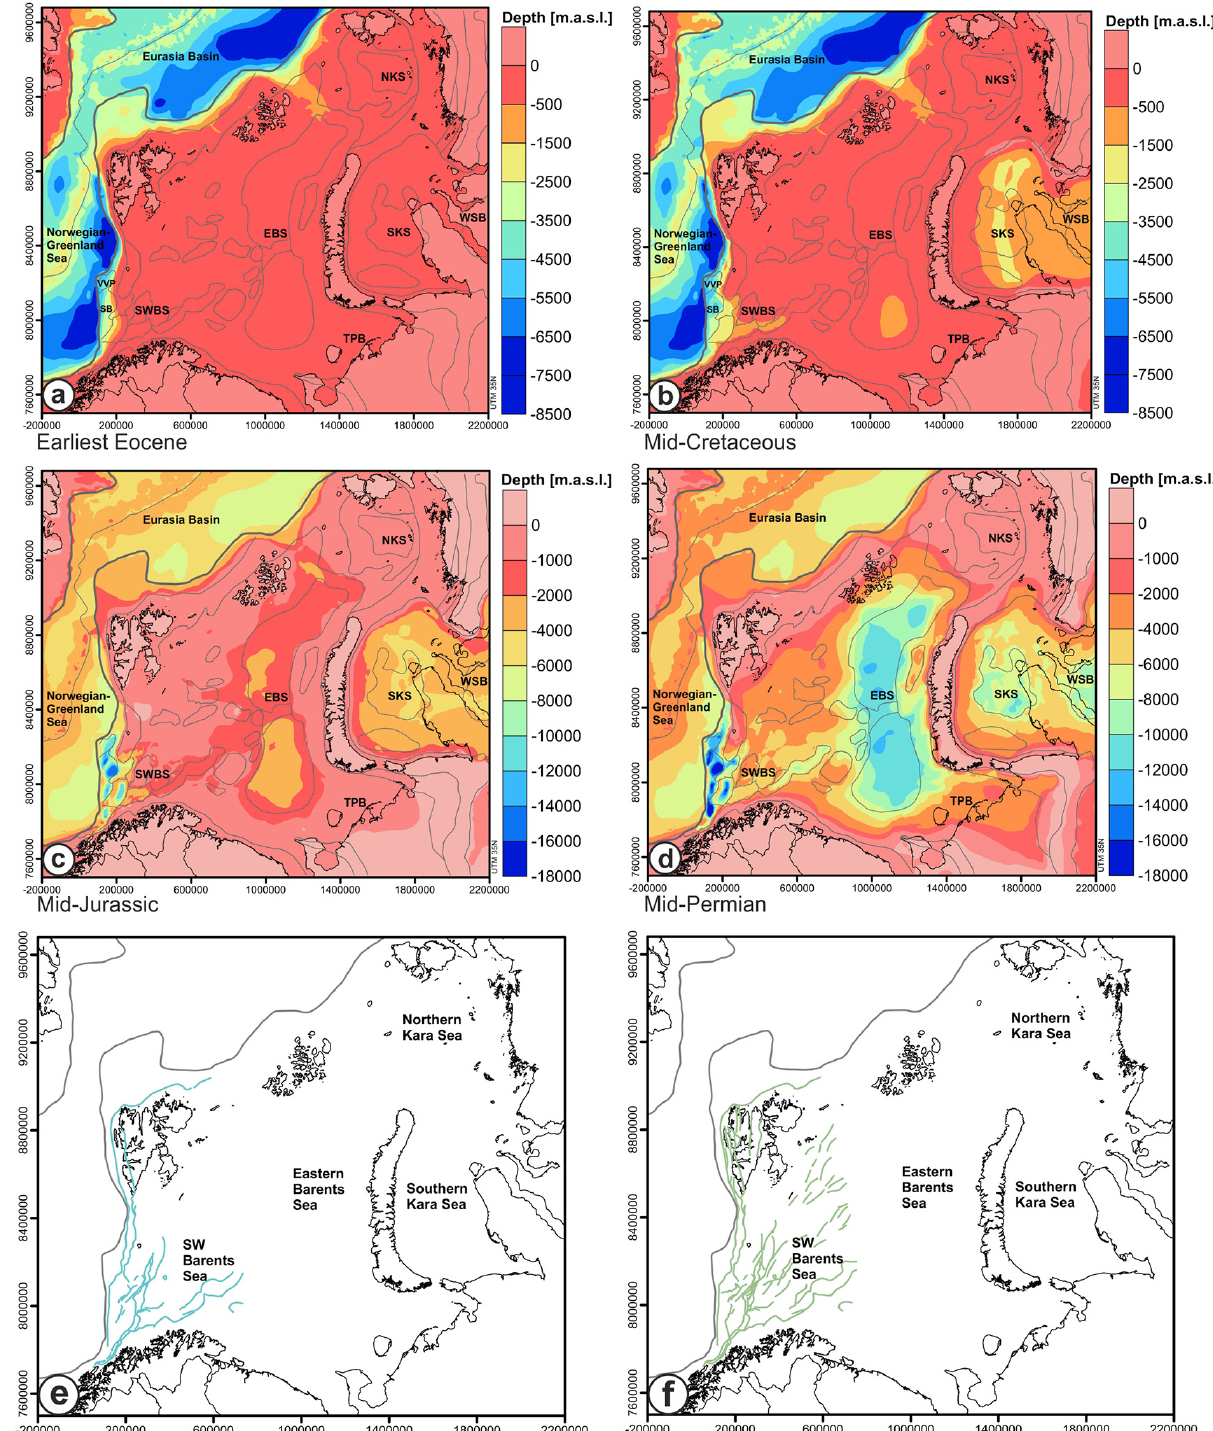
Figure 3. Depth to the four modelled megasequence boundaries: (a) earliest Eocene (b) mid-Cretaceous (c) mid-Jurassic (d) mid-Permian. The grey lines delineate structural features in the study area. The earliest Eocene surface equals the top crystalline crust in the oceanic domain. See Table 1 for the database. (EBS) – eastern Barents Sea; (NKS) – northern Kara Sea; (SB) – Sørvestsnaget Basin; (SKS) – southern Kara Sea; (SWBS) – southwestern Barents Sea; (TPB) – Timan–Pechora Basin; (VVP) – Vestbakken Volcanic Province; (WSB) – West Siberian Basin. Mesozoic (e) and Paleozoic (f) fault-sets (Faleide et al., 1993, 2008, 2010; Gudlaugsson et al., 1998) cover the western Barents Sea and were used as vertical interpolation barriers for the respective megasequence